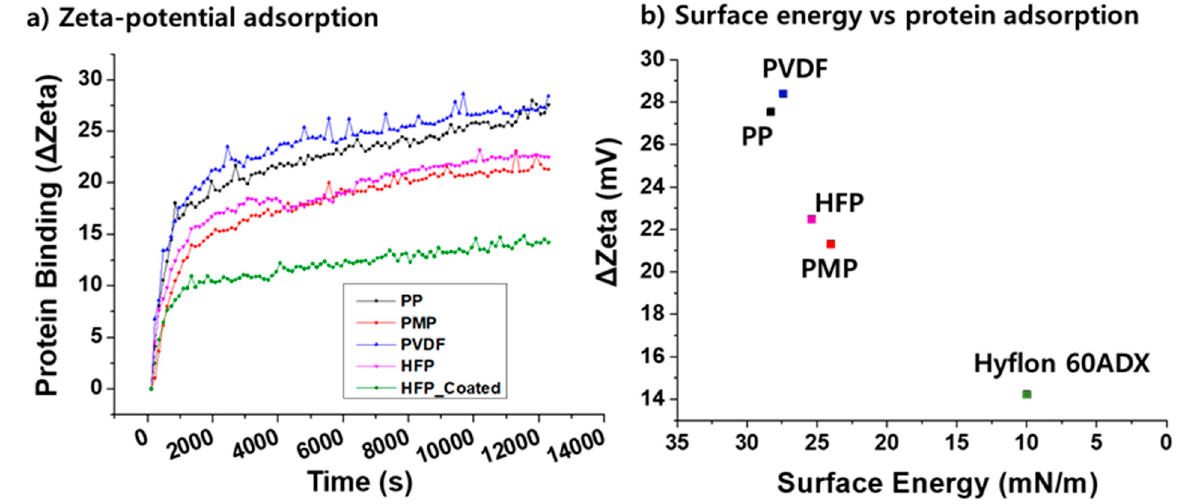
Figure 8. ( a ) Rate of protein adsorption measured by streaming zeta-potential device, ( b ) inverse correlation between material surface energy and the amount of protein adsorption. (Reprinted with permission from [50].).